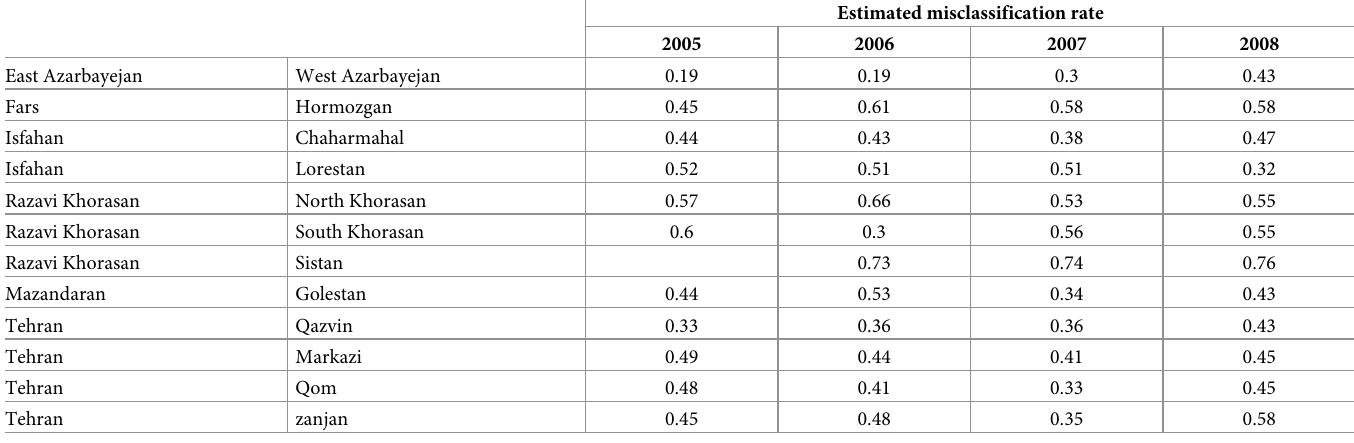
Table 2. Bayesian estimated from misclassification rate between provinces